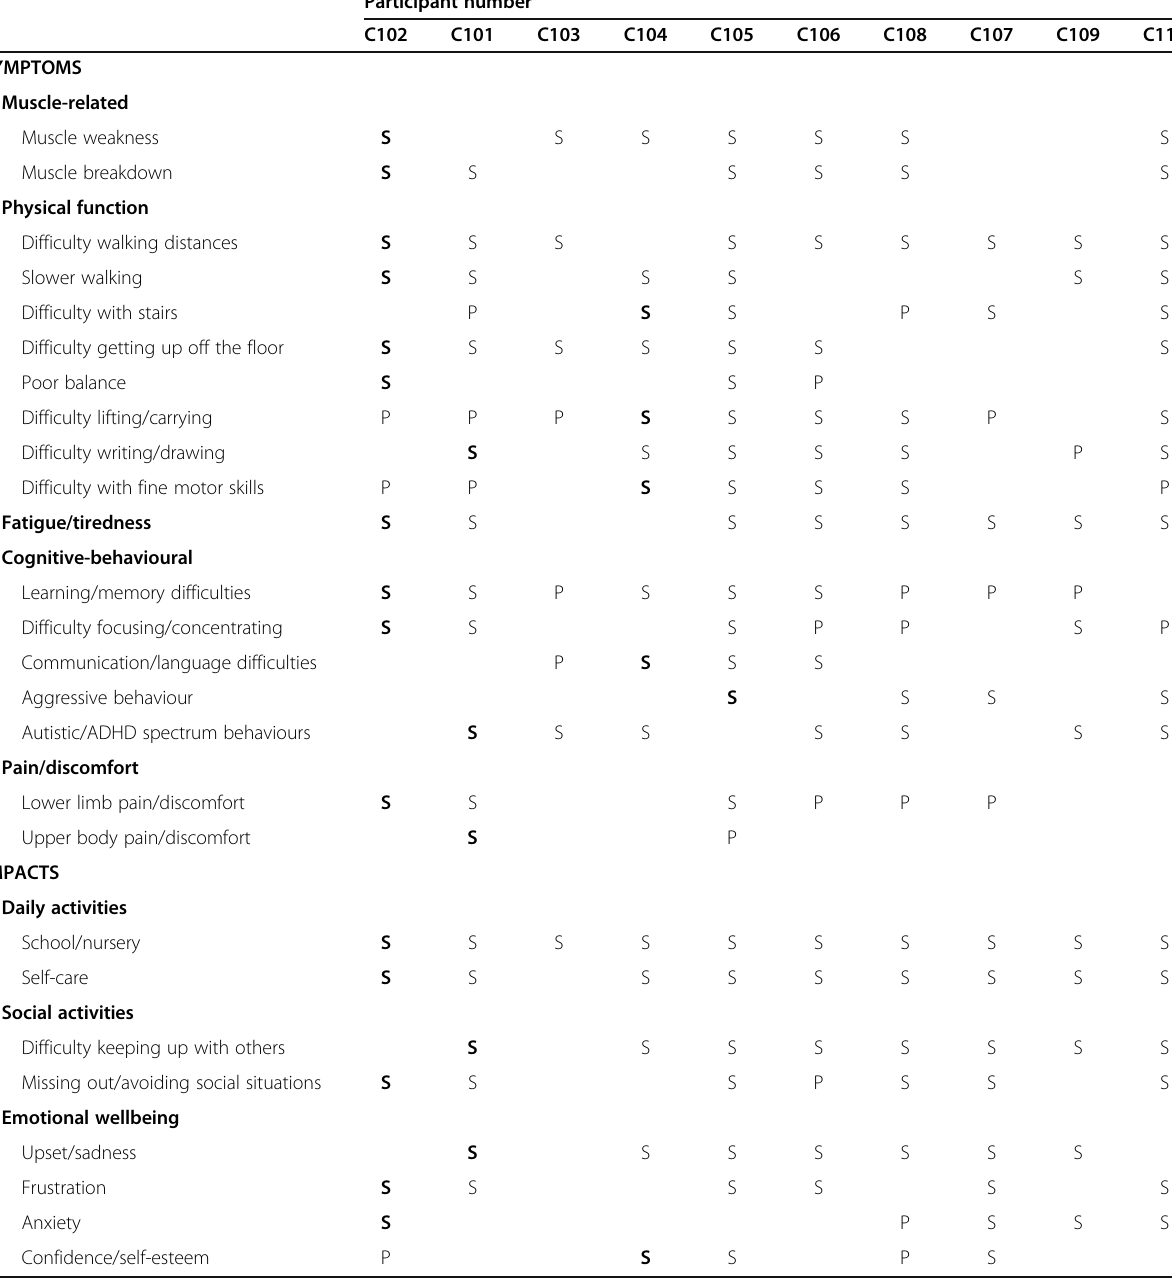
Participant number